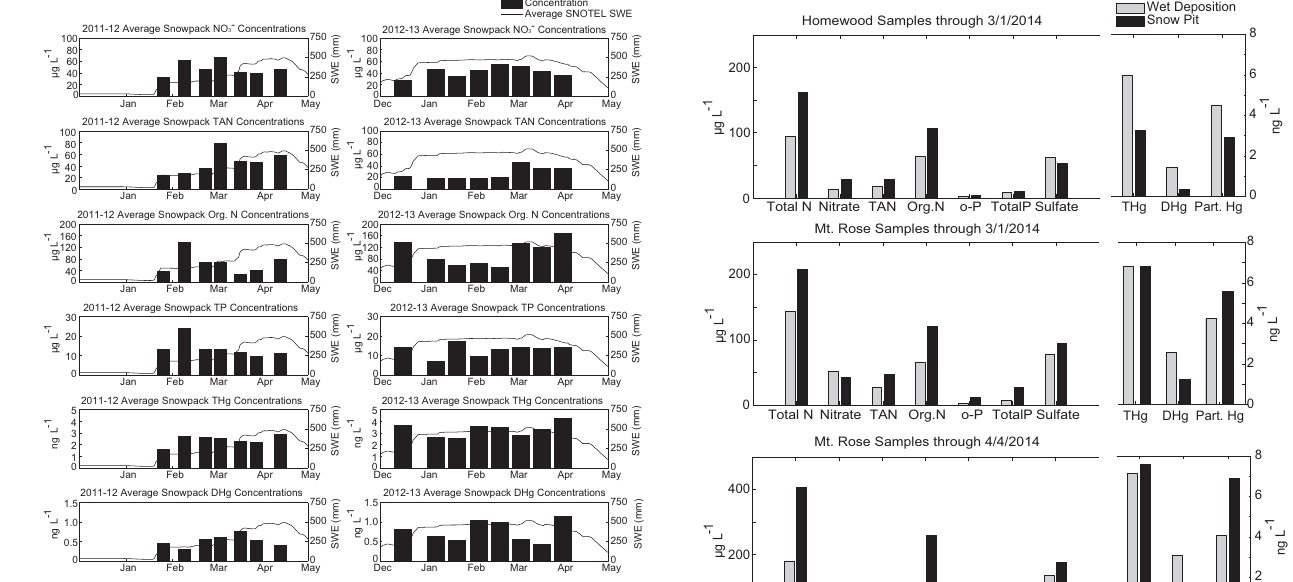
Figure 4. Average snowpack core concentrations during 2011–2012 (left) and 2012–2013 (right) snow seasons along with average SWE estimated from six SNOTEL sites located within the Tahoe Basin. Figure 5. Comparison of seasonal average volume-weighted wet deposition concentrations with integrated snow pit samples from the 2013–2014 snow